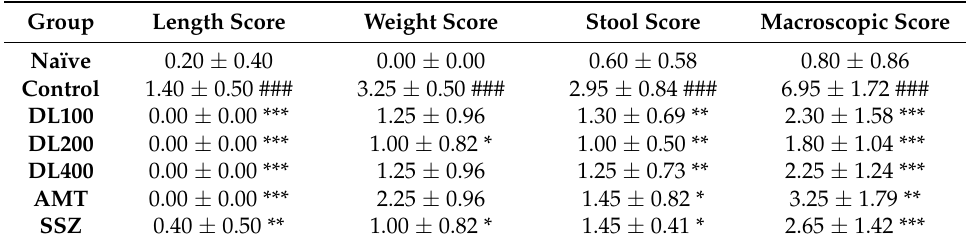
Figure 2. Animal experimental scheme. DL, Dolichos lablab L. extract; AMT, amitriptyline; SSZ, sulfasalazine; EPM, elevated plus maze; OFT, open field test. Table 1. Macroscopic score of zymosan-induced colon changes.